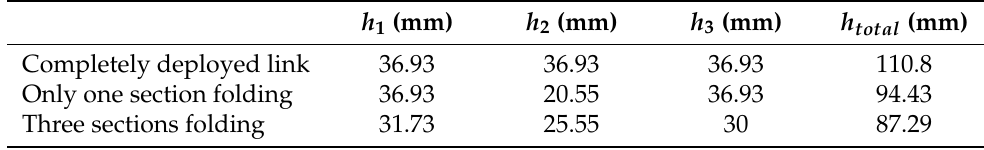
Table 4. Three-sections link kinematics simulation